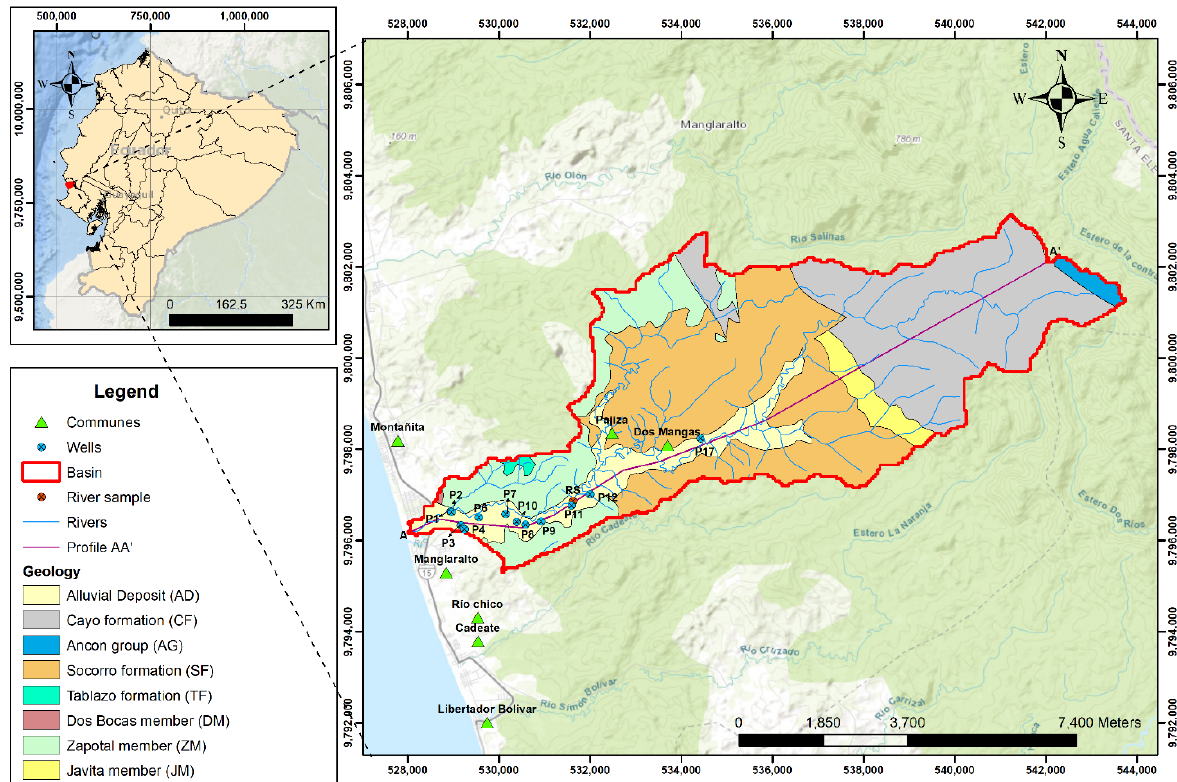
Figure 1. Map of the Manglaralto river basin, geology, location of wells, and river sample.